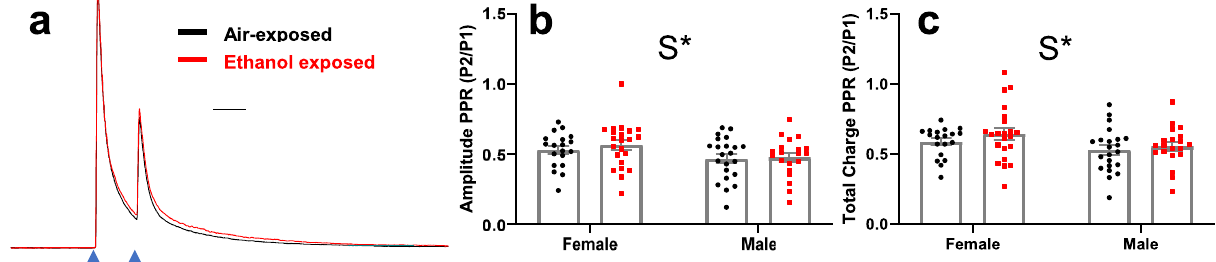
Figure 7. Effect of P7 ethanol exposure on optically-evoked inhibitory postsynaptic currents (oIPSCs) paired-pulse ratios in layer V RSC pyramidal neurons at P40–60. ( a ) Average oIPSC PPR current traces from air-exposed (black trace) and ethanol-exposed (red trace) animals, collapsed across sex. Amplitudes of traces from air- and ethanol-exposed animals are normalized to the amplitude of the first peak to illustrate PPRs. Scale bar 40 ms. ( b ) Collected amplitude PPRs for all cells from air-exposed (black circles) and ethanol-exposed (red squares) animals. ( c ) Collected total charge PPRs for all cells from air-exposed and ethanol-exposed animals. Asterisk (*) denotes a p-value of p < 0.05. Please see Supplemental Table S2 for exact p-values. S = sex effect. Air female n = 19 cells from 5 animals from 4 litters, air male n = 22 cells from 6 animals from 5 litters; ethanol female n = 22 cells from 6 animals from 5 litters; ethanol male n = 20 cells from 5 animals from 5 litters. Data are presented as mean ±